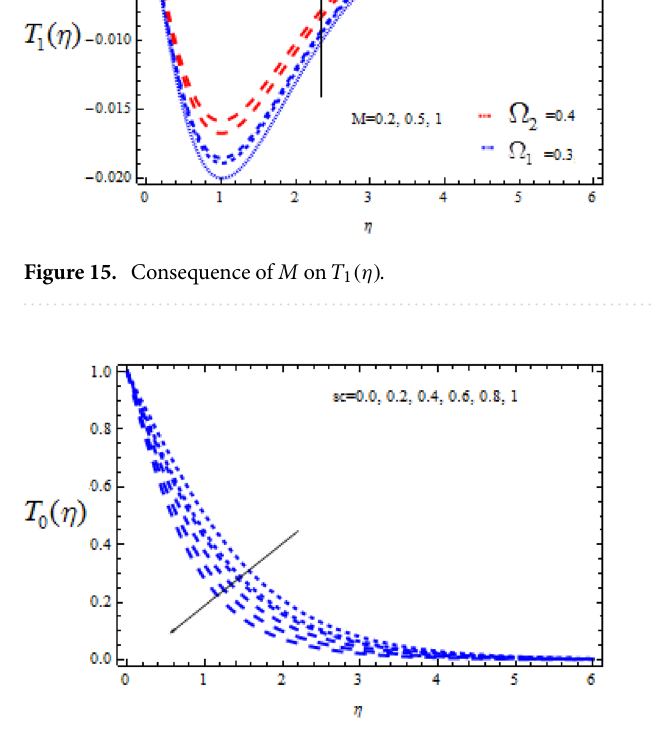
Figure 16. Consequence of Sc on T 0 (η)